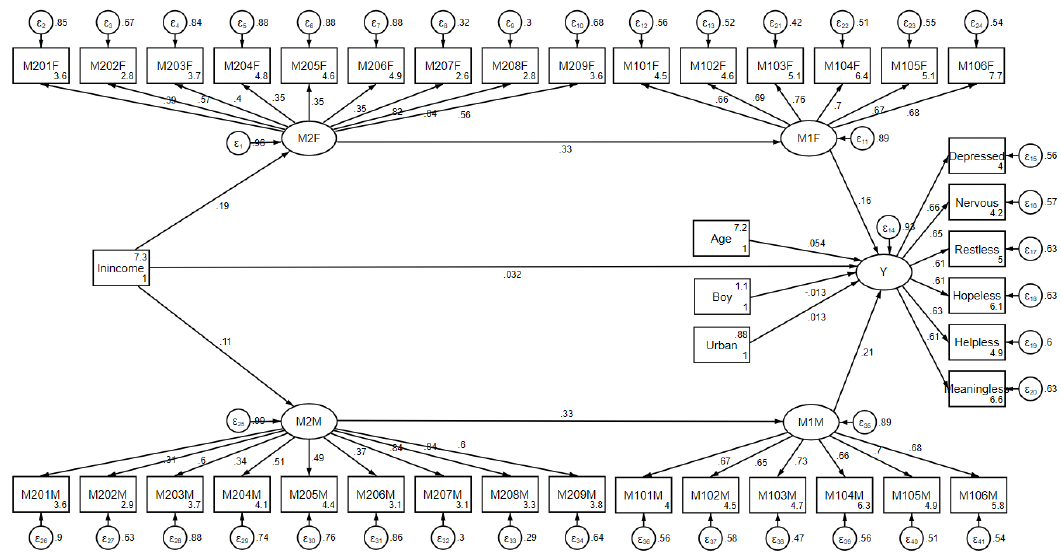
Figure 4. Structural equation model describing the mediation of parents’ life satisfaction and emotional wellbeing.